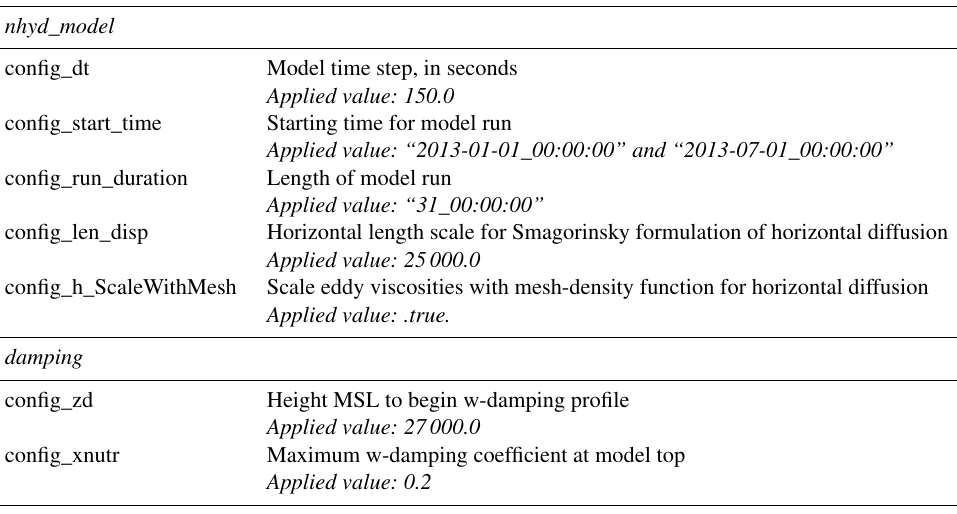
Table 1. MPAS-A non-default namelist configuration variables used for testing (except physics